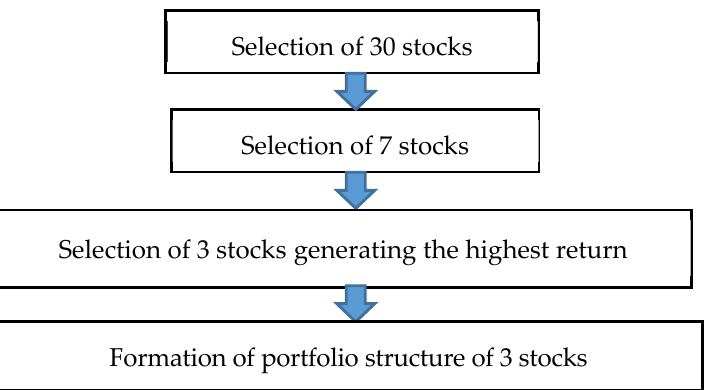
Figure 2. Stock selection scheme for the portfolio (source: compiled by the authors). When constructing a portfolio, a risky stock that may still generate the right level of return for the portfolio by the end of the day should not be eliminated. This share should not be included in the list of shares to be sold and repurchased, which would protect the investor from unwanted costs. However, that, jokingly, requires direct contact with the changing stock price. This contact can be made with a properly formed trailing stop-loss order. It is true that, in the case of a daily step, and even more so by significantly shortening the investment step, the possibilities of stop loss and trailing stop-loss orders